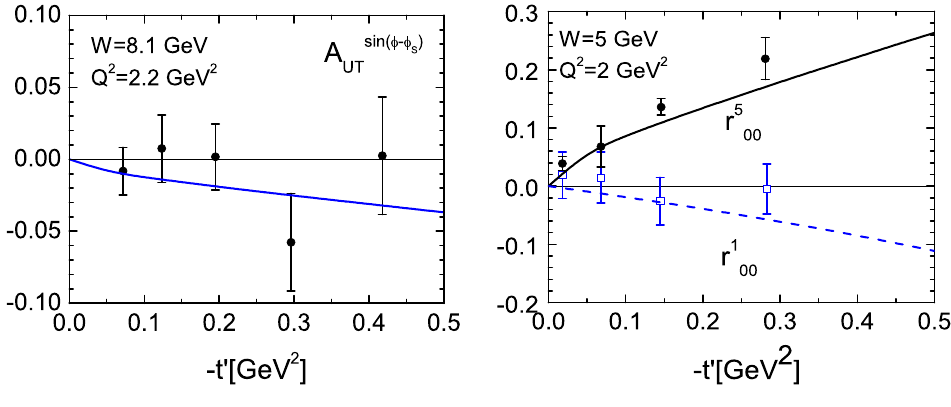
Figure 3. Left: The t (cid:3) dependence of the A sin( φ − φ s ) Right: The transversity e ff ects in SDME for the ρ production at